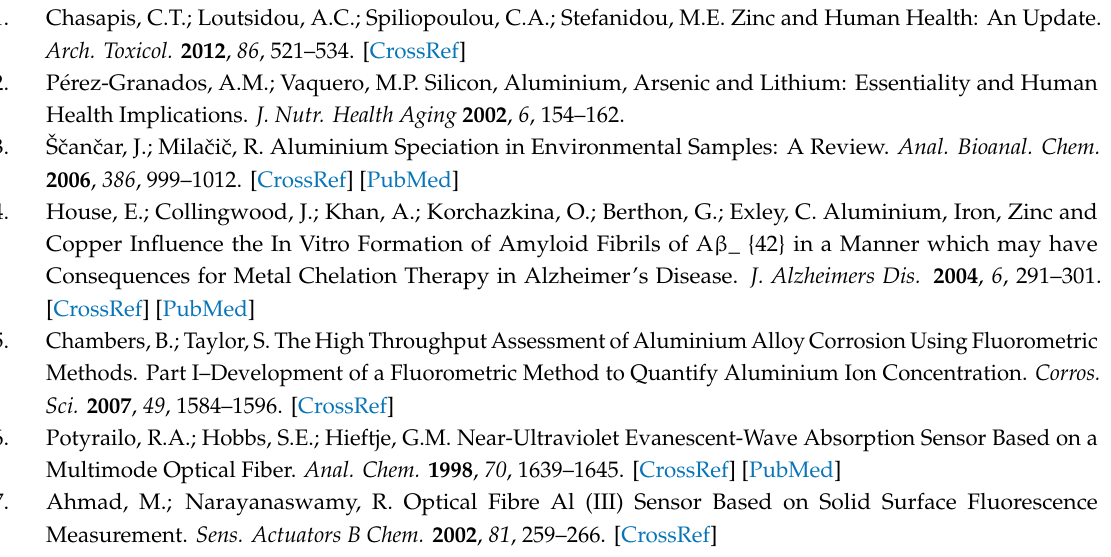
Figure S1: Schematic of plasma reactor and custom- built fiber holder, Figure S2: Schematic showing the coupling of lumogallion derivative with plasma polymerized ECF, Figure S3: Schematic of optical